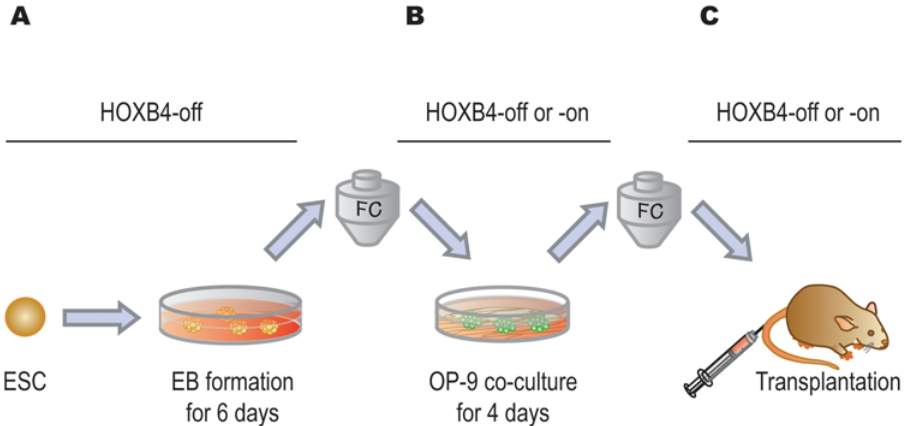
Figure 1. Study design. (A) iHOXB4 ESCs were differentiated into EBs for 6 days in the presence of Dox. (B) Dissociated EB cells were analyzed and sorted by flow cytometry (FC). EB cells or their subpopulations were co-cultured with OP9 cells for 4 days in the presence or absence of Dox. (C) Co- cultured cells were analyzed and GFP + cells were sorted by FC when HOXB4 expression was turned on. Regardless of HOXB4 status in co-cultures, FC sorting was performed on co-cultured cells based on forward and side scatters and on surface markers. Sorted cells were subjected to long-term reconstitution assays. The sorting process turned out to be useful for cell counts, removal of dead cells, and elimination of the remaining Dox.